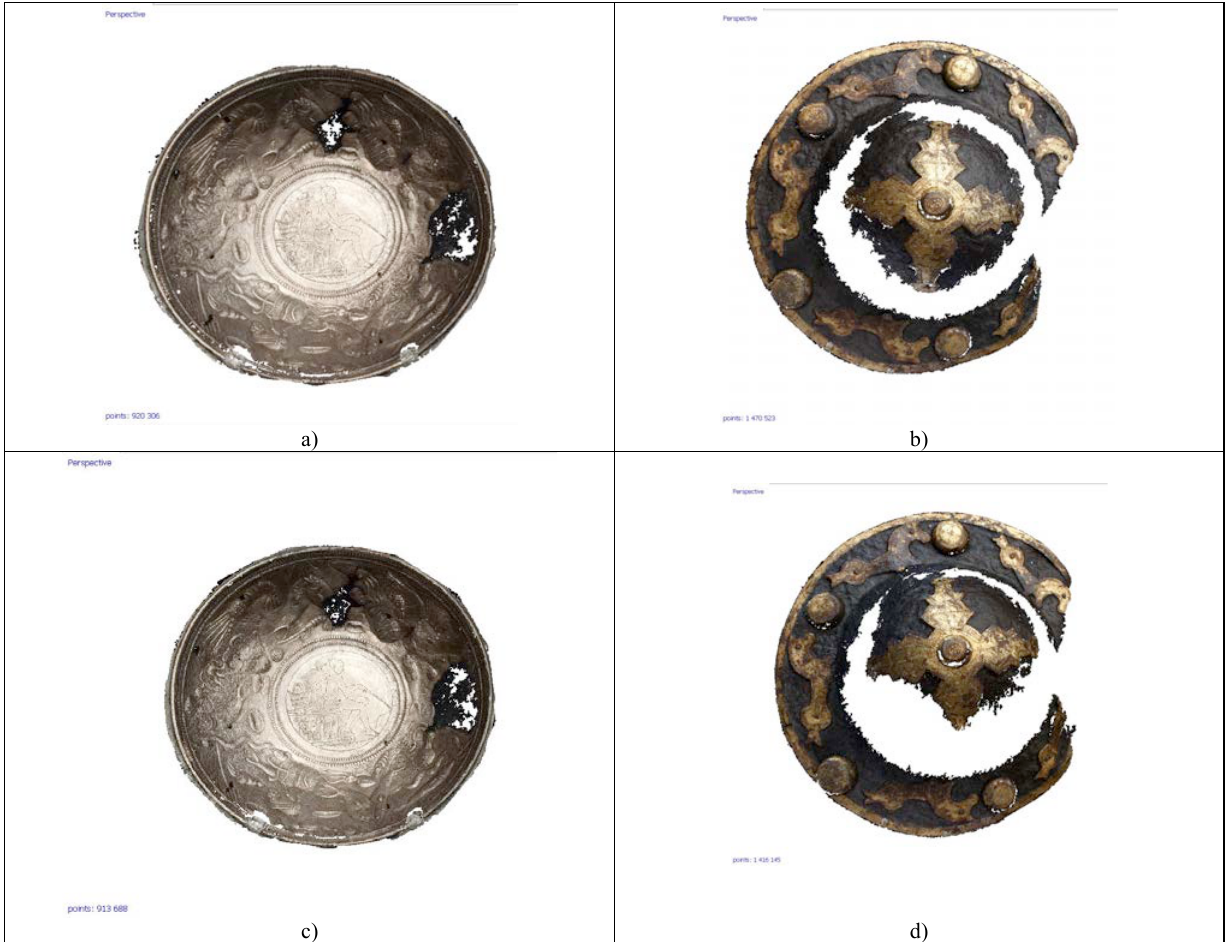
Figure 5. Image matching results on the metallic test objects with and without polarizing filter: a, c) Patera; b, d) Umbo. The first row (a, b) acquired without any polarizing filter while the second (c, d) with polarizing filter. The two results show no significant